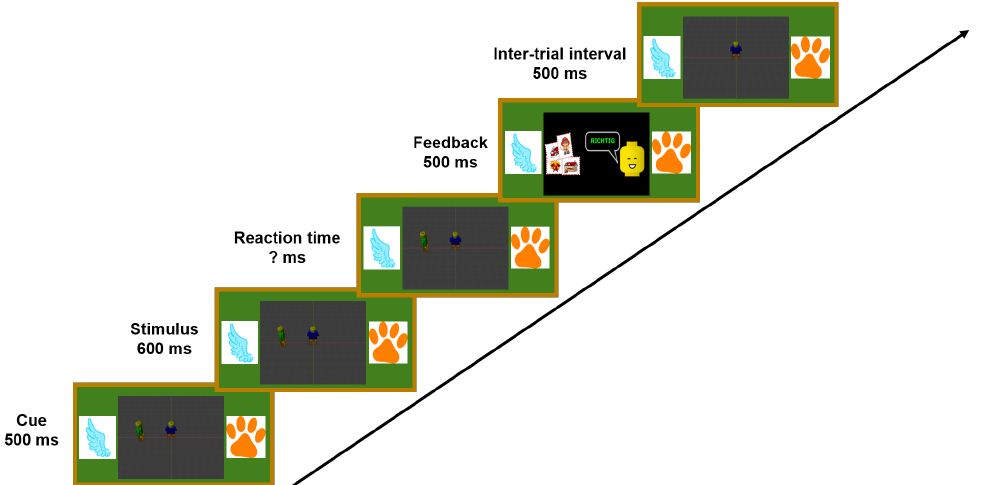
Figure 2. Schematic of the trial structure including the instructions on the virtual blackboard and all experiment